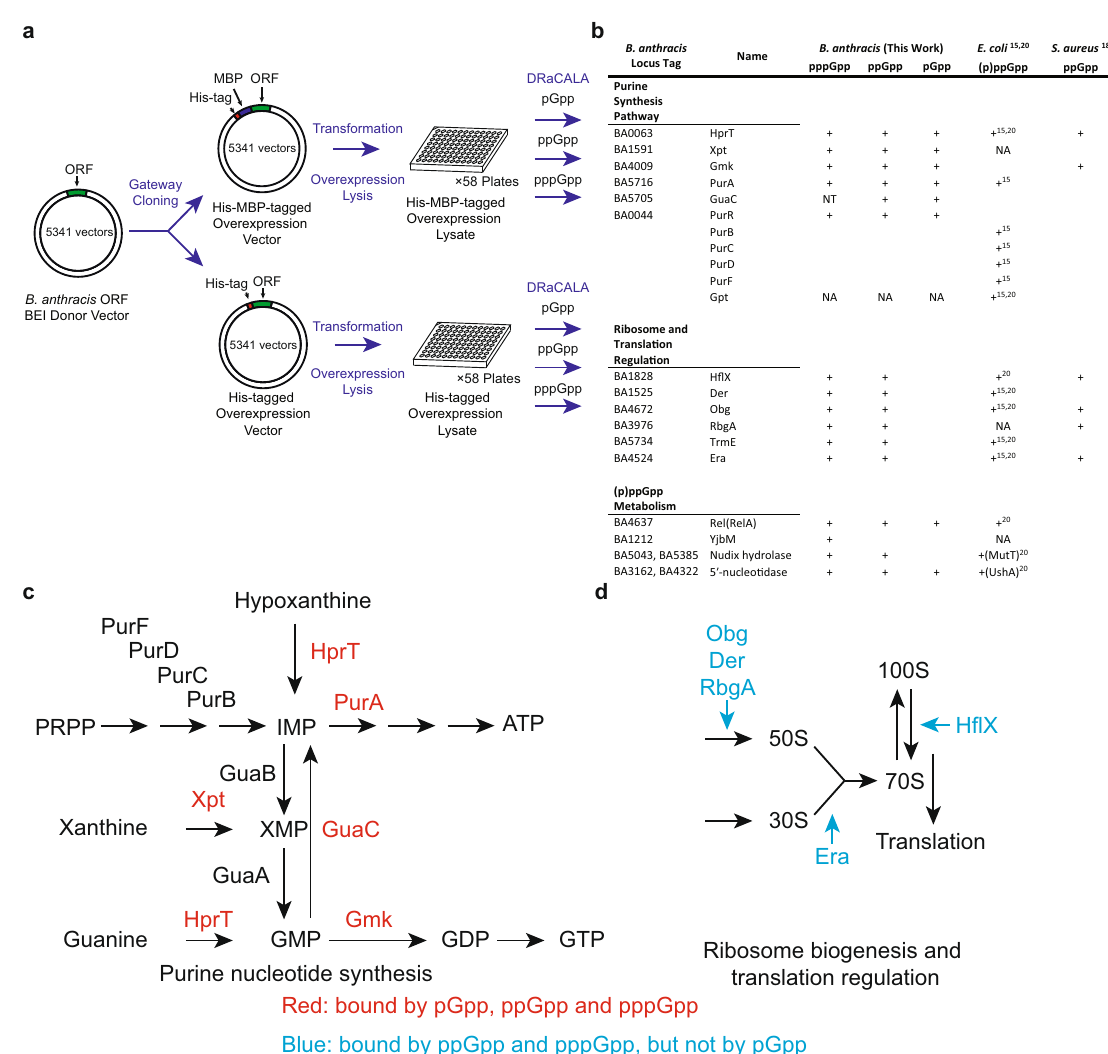
Fig. 1 Proteome-wide DRaCALA screen identi fi es both conserved categories of binding targets and novel targets. a The Bacillus anthracis ORF donor vector library was recombined by Gateway cloning into overexpression vectors to generate ORFs with an N-terminal His-tag or HisMBP tag. The plasmids were transformed into E. coli for overexpression of recombinant proteins. Lysates of each ORF overexpressed in E. coli were assayed for binding to pppGpp, ppGpp, and pGpp using DRaCALA. b List of identi fi ed (p)ppGpp-binding targets in E. coli , S. aureus , and B. anthracis and pGpp-binding targets in B. anthracis . pppGpp results were obtained using both His-tagged and His-MBP-tagged proteins. ppGpp and pGpp results were obtained using His-MBP-tagged proteins. NT not tested, NA not available due to the lack of homologous gene. c , d Schematics of pathways differentially regulated by pGpp and (p)ppGpp: c Enzymes in purine nucleotide synthesis, including HprT, Xpt, Gmk, and GuaC, bound both pGpp and (p)ppGpp; d GTPases, involved in